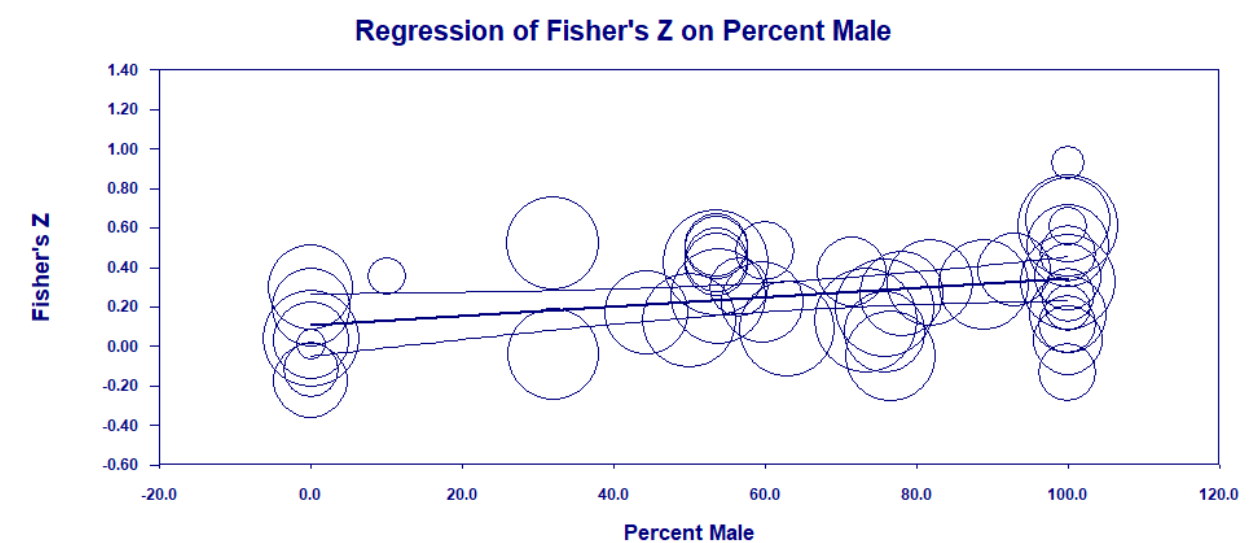
Figure 4. Meta-regression plot of the relationship of percent male in each study sample and the overall self-confidence and sport performance relationship, R 2 = 0.22, F (1,43) = 6.62, p < 0.01, Goodness of fit Q(43) = 112.73, p < 0.0001, expressed as Fisher’s Z. Larger circles represent studies with more participants. Middle line is the regression line; the upper and lower lines are the 95% confi- dence intervals.